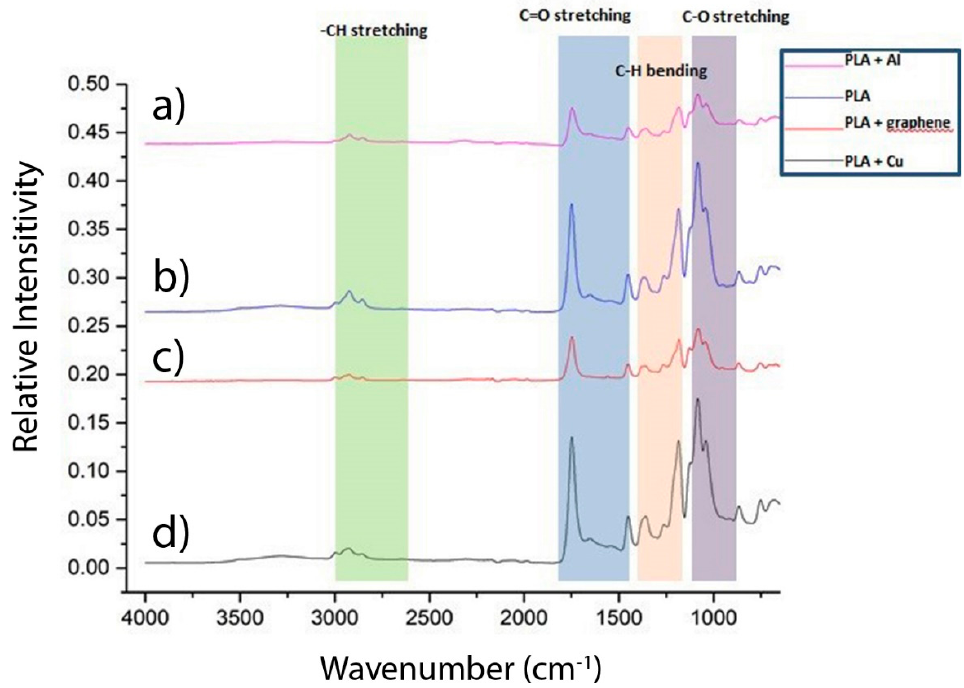
Figure 10. Fourier transform infrared (FTIR) spectra of experimental samples: a—polylactic acid material with aluminum particles (PLA + Al); b—polylactic acid material (PLA); c—polylactic acid material with graphene particles (PLA + graphene); d—polylactic acid material with copper particles (PLA + Cu).